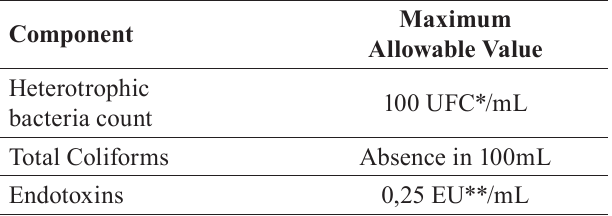
TABLE I - B iological and microbiological quality standard